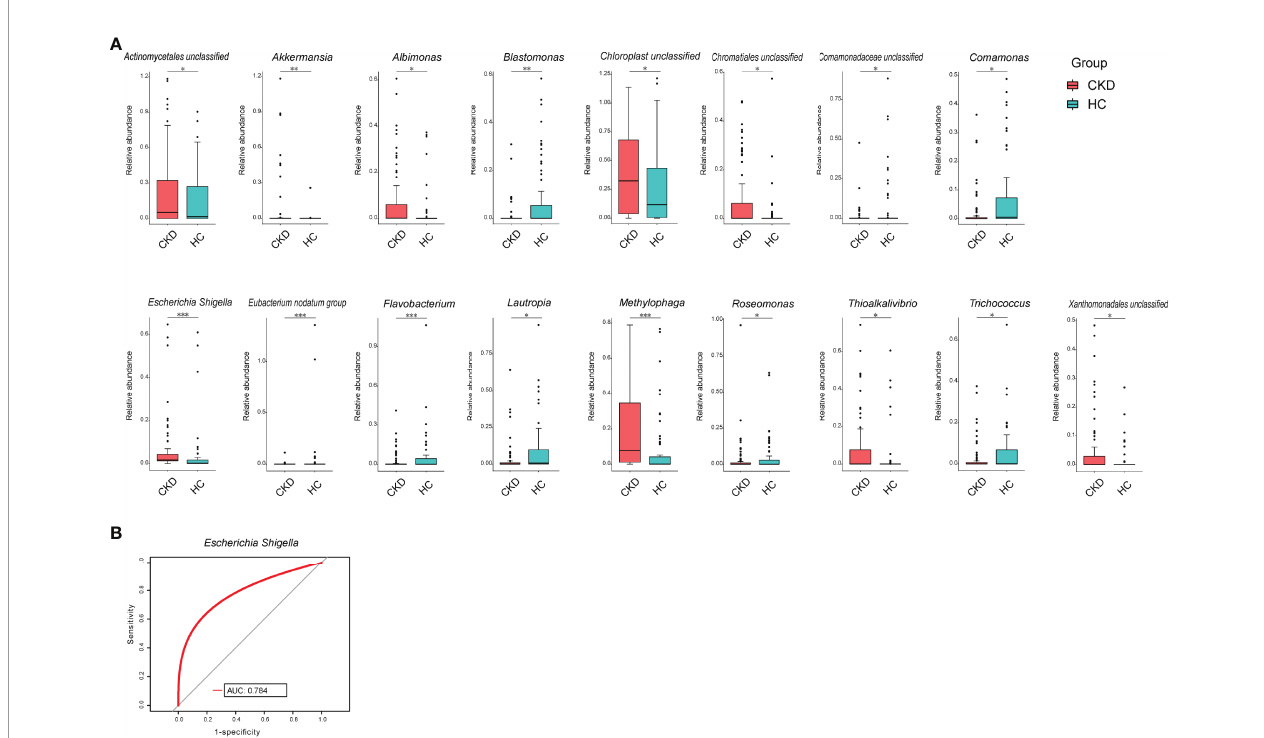
FIGURE 2 | Bacterial comparison between CKD and HC. (A) Bacterial genera that were differentially abundant between CKD patients and HCs. Only the genera with above 1 ‰ are displayed. p -value was calculated using Wilcoxon rank-sum test and adjusted by Benjamini and Hochberg false discovery rate (FDR). * p < 0.05, ** p < 0.01, and *** p < 0.001. (B) Receiver operating characteristic curve (ROC) curve for validation of bacterial classi fi cation of CKD from